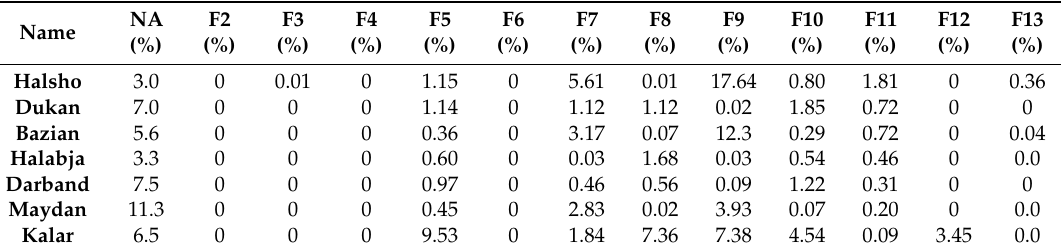
Table 6. The ratio of NA and error flags at automatic stations.